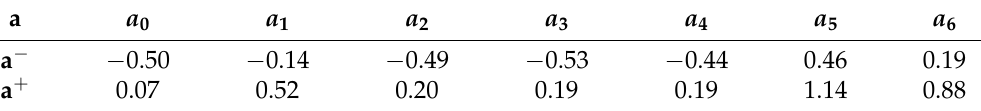
Table 1. Parameter ranges for the model.